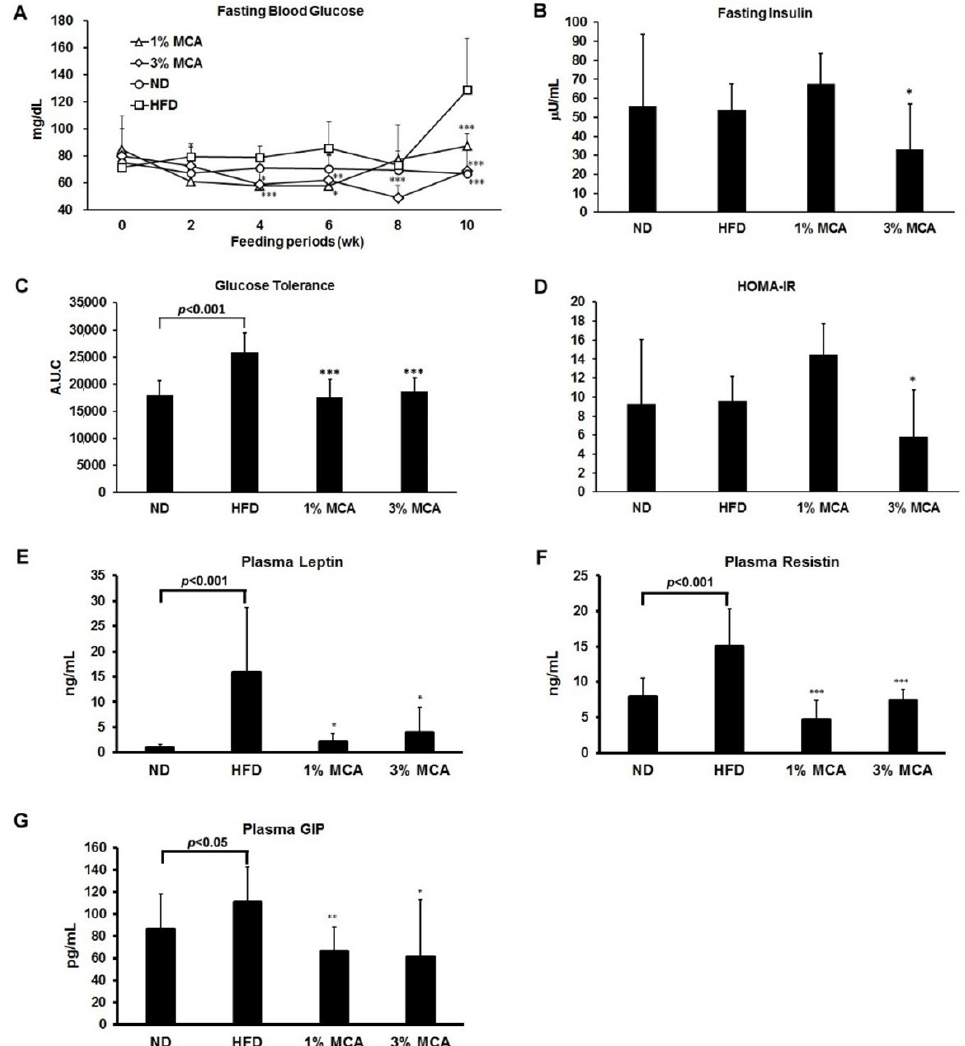
Figure 3. The effect of MCA on insulin resistance and adipocytokines and glucose-dependent insulinotropic polypeptide (GIP) in HFD-fed mice. ( A ) Fasting blood glucose level changes during 10 weeks of MCA treatment. ( B ) Plasma insulin levels after 12 h of fasting. ( C ) Area under the curve (AUC) of blood glucose and insulin levels. ( D ) The homeostasis model assessment of insulin resistance (HOMA-IR) index calculated using fasting blood glucose and insulin levels. Changes in the levels of plasma adipocytokines, leptin ( E ), and resistin ( F ), and GIP ( G ). Data are shown as means ± SEM. HFD vs. MCA, * p < 0.05; ** p < 0.01; *** p < 0.001.